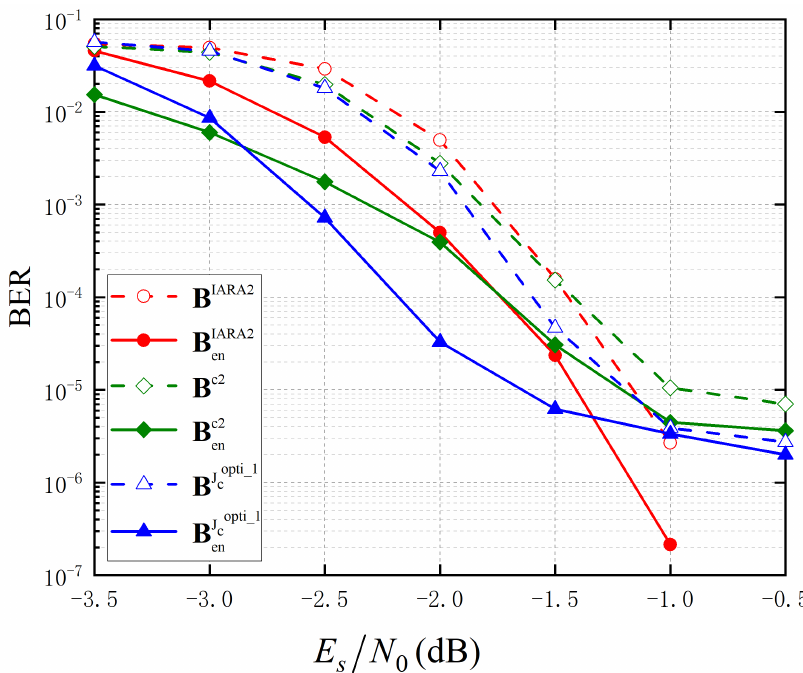
Figure 4. Simulated BER results of the enhanced and the benchmark codes at p =